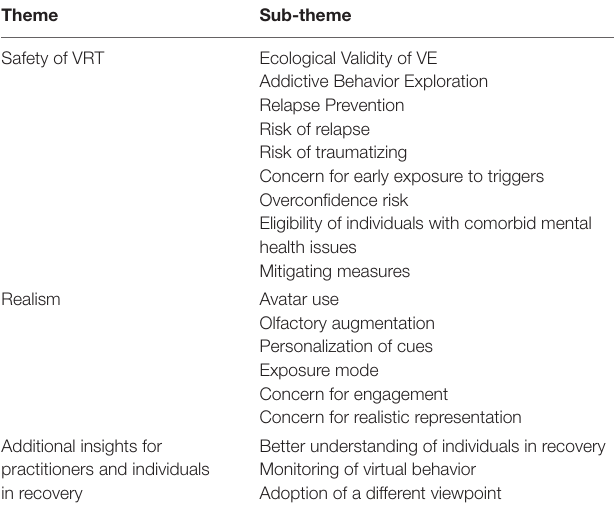
TABLE 2 | Themes and sub-themes of the thematic